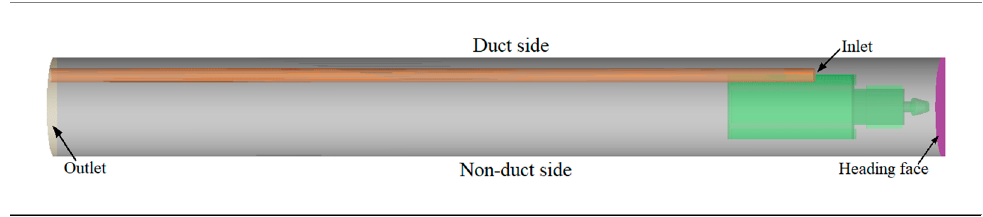
Figure 1. The geometry of underground laneway [20].